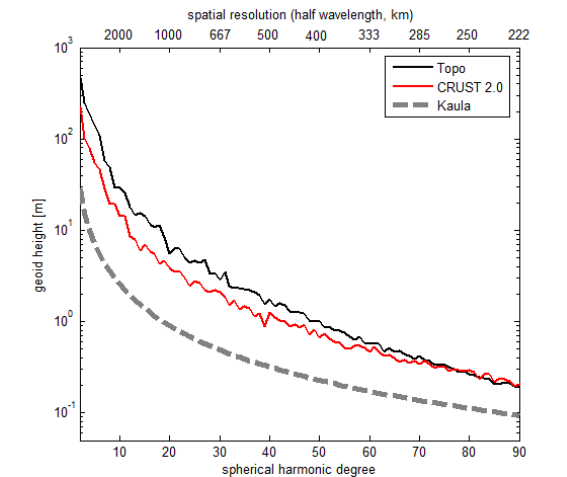
Figure 3. RMS degree variances expressed in geoid heights of the uncompensated topography (Topo), the t/i model obtained fromtheanalysisofthelayeredinformationofcrustalmodel CRUST 2.0 and Kaula’s rule. Unit is m.